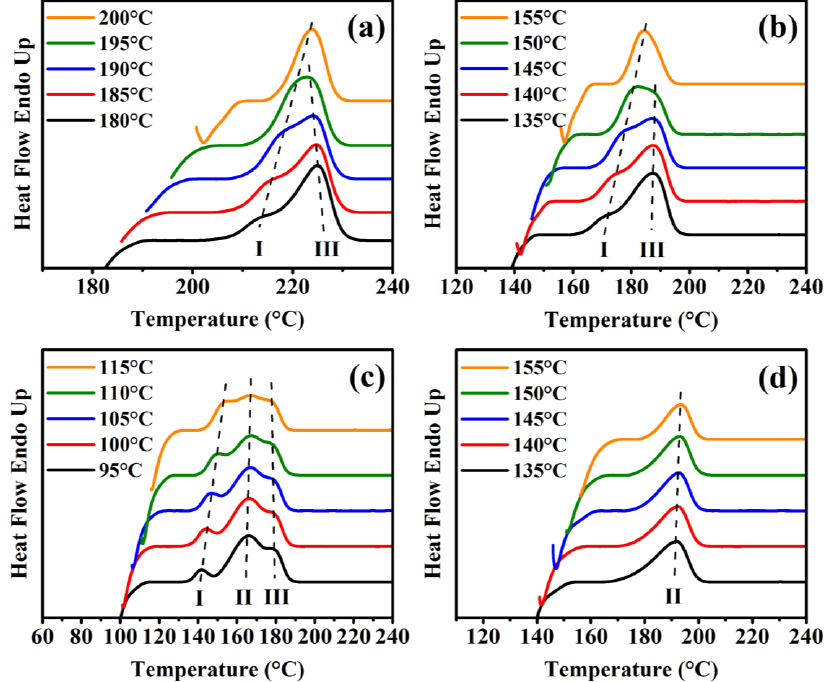
Figure 2. The melting temperatures at different isothermal processes for ( a ) pure PA6, ( b ) PA6-5, ( c ) PA6-10, and ( d ) PA6-15.